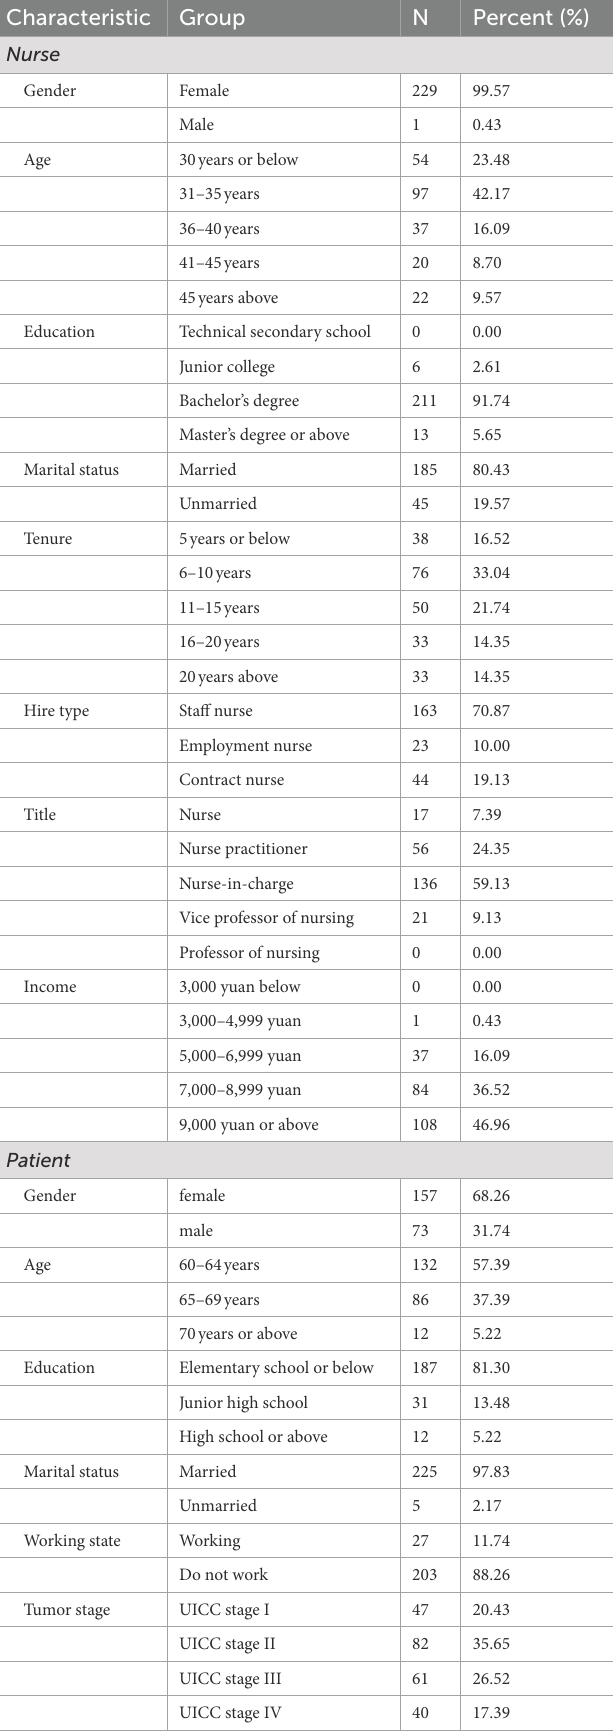
TABLE 1 The demographic information of the